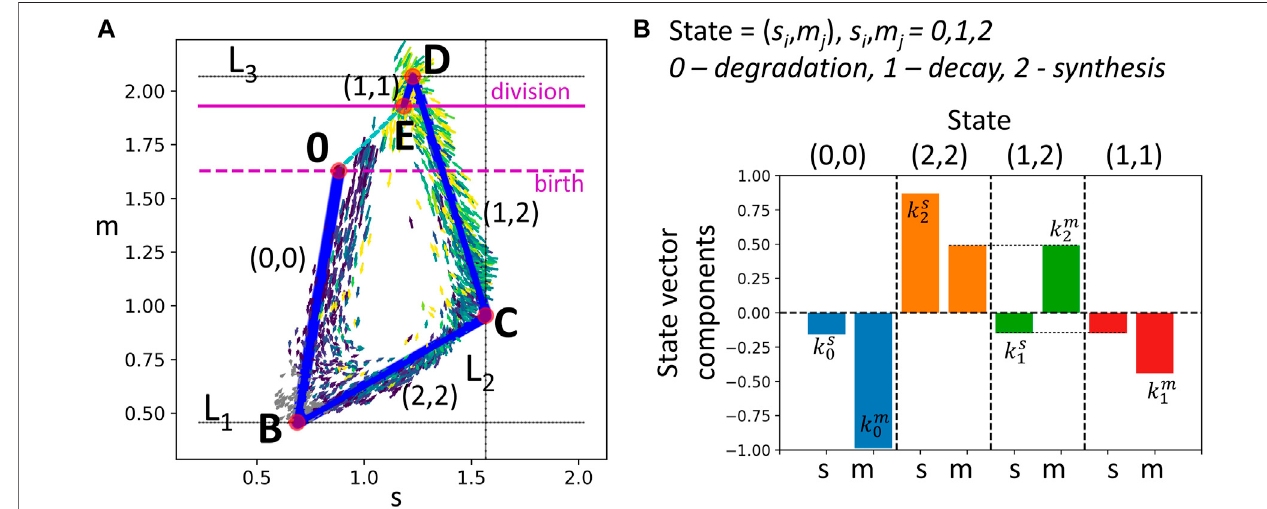
FIGURE3| Modelingtranscriptomiccellcycletrajectorybyanallometricgrowthwithswitches. (A) Piecewiselinearcellcycletrajectory fi ttothesinglecellRNASeq data (cell cycle trajectory, shown in Figure 1A ,right). The model contains three switching planes L 1 , L 2 , L 3 , and is characterized by four states. The states are encoded with two triggers, each possessing three possible levels 0,1,2, the biological meaning of which is speci fi ed in B). (B) The growth vectors associated with each state are encoded by rates k S i , k M j , such that the components of the growth vectors equal ( k S i , k S j ) , where i and j are the levels of the corresponding